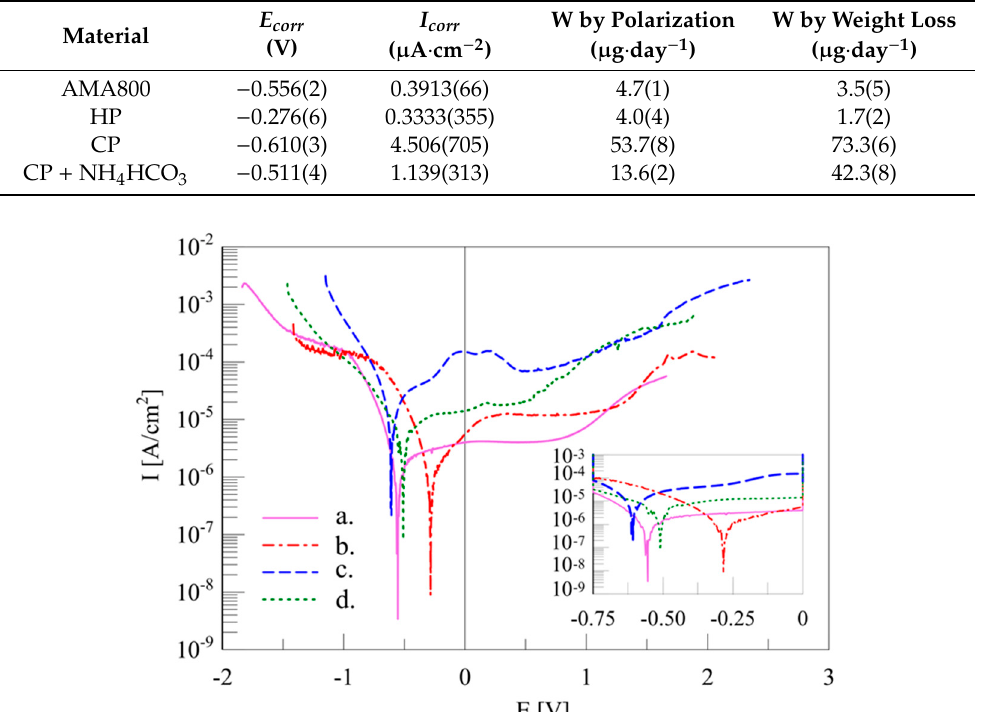
Figure 5. Potentiodynamic test result curves of Ti23Mo alloys obtained by different processing approaches in Ringer solution: Arc melted and annealed at 800 °C/24 h ( a ), MA for 48 h and hot pressed at 800 °C/5 min ( b ), cold-pressed and sintered at 800 °C/0.5 h ( c ) and cold-pressed with NH 4 HCO 3 and sintered at 1150 °C/10 h ( d ).